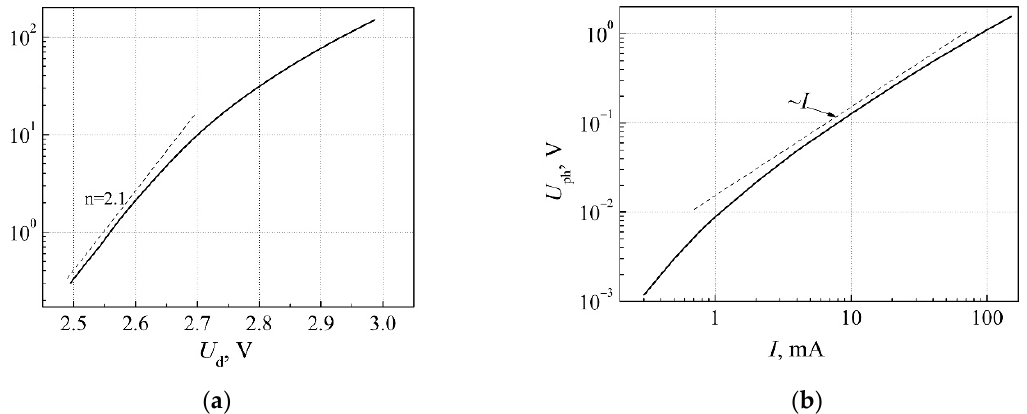
Figure 5. ( a ) Typical current−voltage characteristic ( n is the non-ideality factor); ( b ) typical photodetector voltage (proportional to the emitted light power) dependence on d.c. current of white LED. Reprinted with permission from [21].